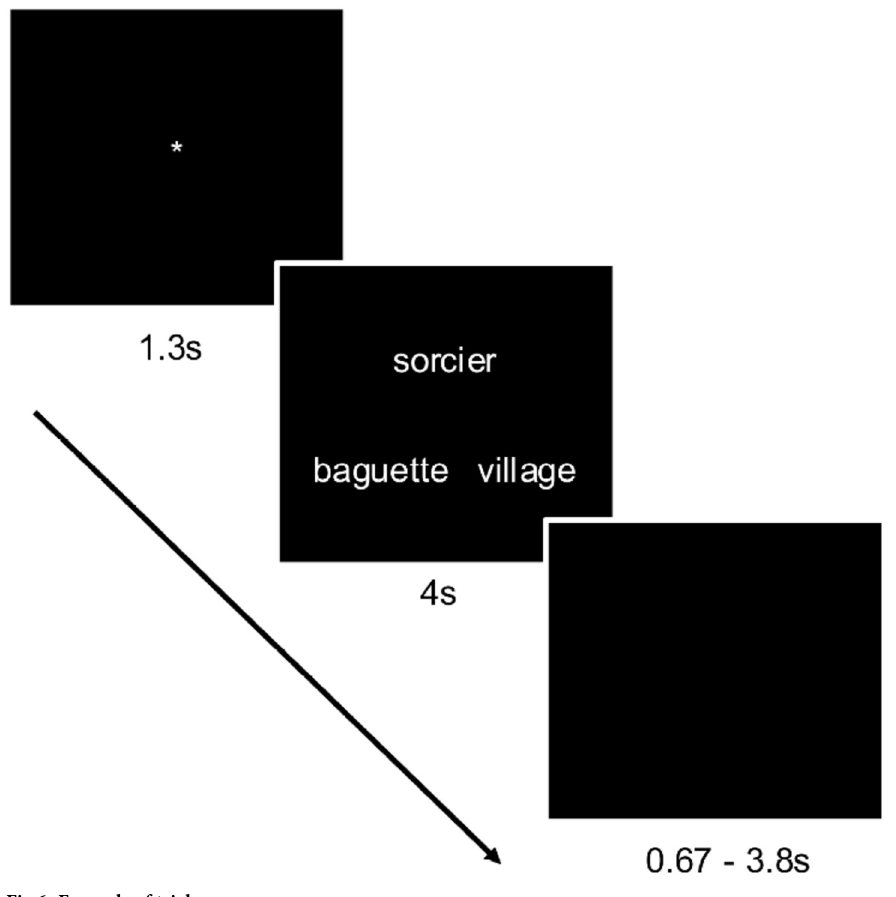
Fig 6. Example of